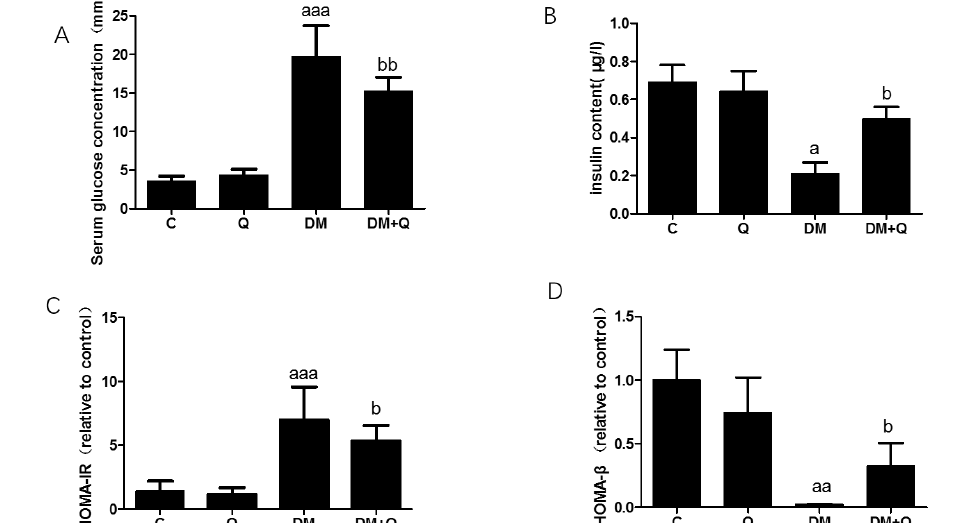
Figure 1. Induction of diabetes and measurement of pancreas function following high-fat feeding and streptozotocin injection and quercetin attenuates symptoms of T2DM in mice. ( A ). serum glucose concentration was measured by standard commercial assays kits. (mmol/L) ( n = 10); ( B ). Insulin levels were determined by mouse-specific ELISA kits ( n = 10); (μg/L); ( C ). The homeostasis model assessment of insulin resistance (HOMA-IR) = fasting insulin × fasting blood glucose/22.5 ( n = 10); ( D ). The homeostasis model assessment of β cell function (HOMA- β ) = 20 × fasting insulin/(fasting blood glucose − 3.5 mmol / L) ( n = 10). Data were expressed as mean ± SD (a: p < 0.05 vs. C; aa: p < 0.01 vs.